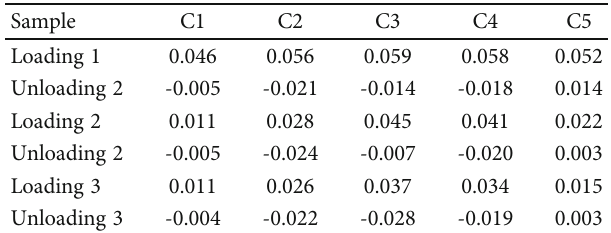
Table 2: Permeability